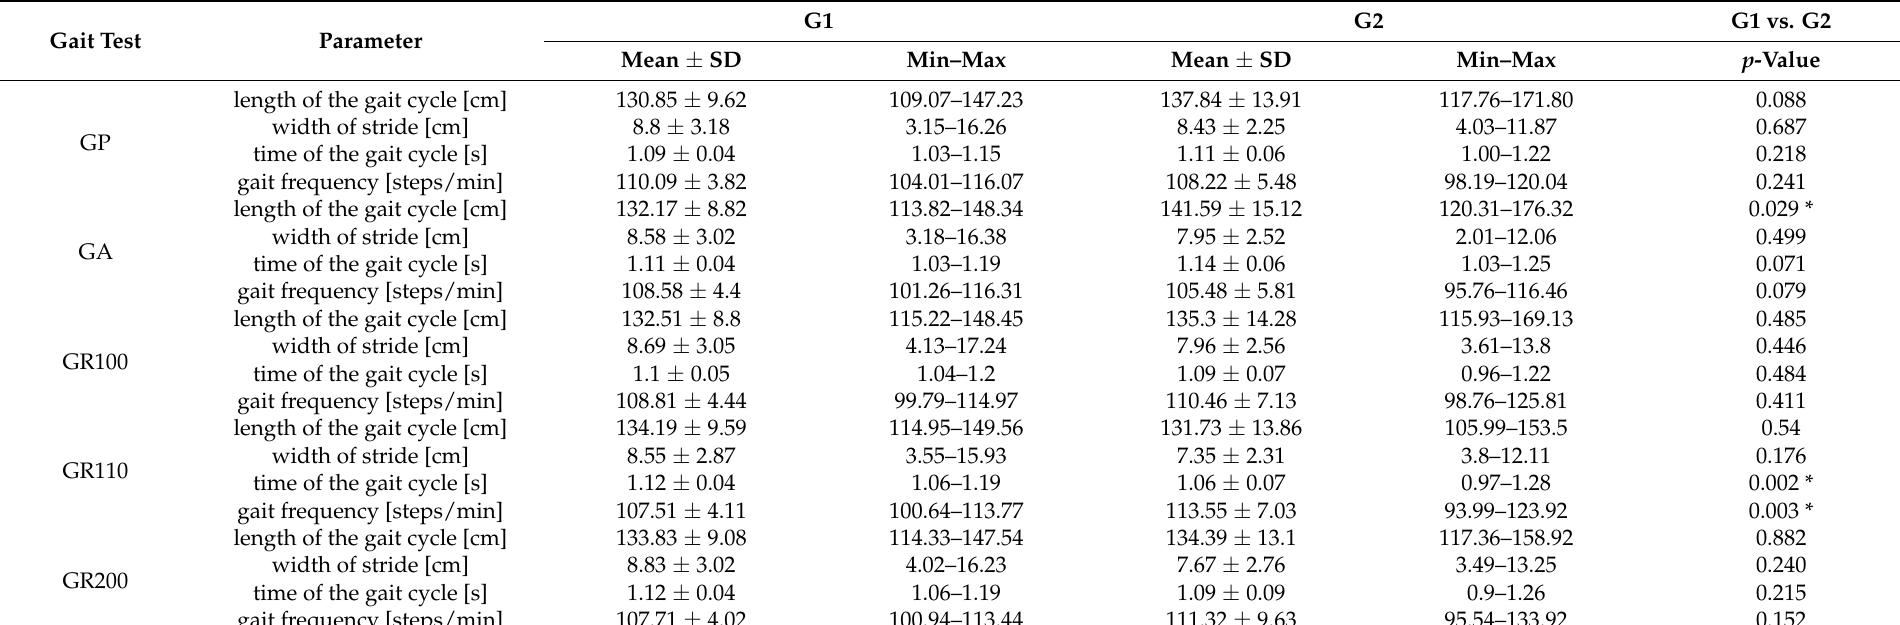
Table 2. Results of time and spatial parameters of gait in tests GP, GA, GR100, GR110, GR200 for groups G1 and